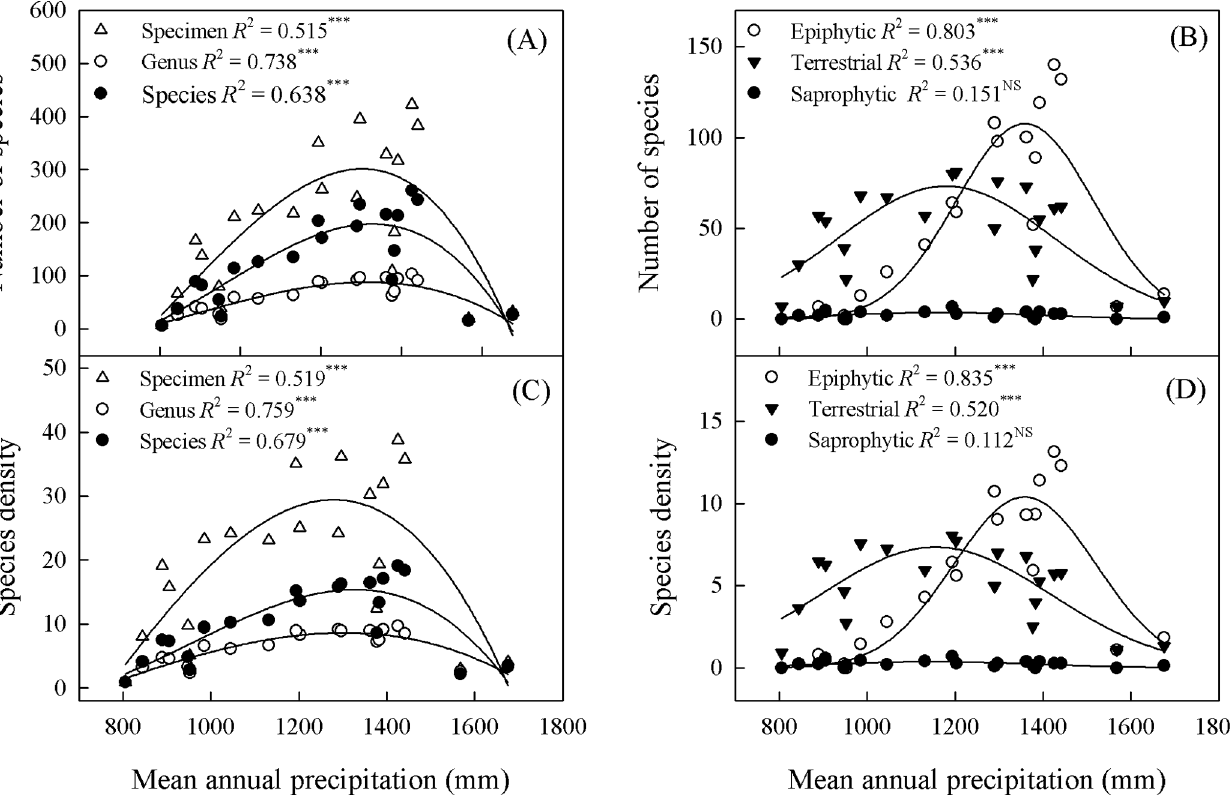
Fig 8. Variations in orchid species richness (SR, panel A-B) and species density (SD, panel C-D) as function of mean annual precipitation (MAP). (A) Specimen: SR = 215.161 − 2.100 * MAP + 0.003 * MAP2 − 1.316 * 10 − 6 * MAP 3 ; Genus: SR = 69.849 − 0.586 * MAP + 0.001 * MAP 2 − 3.545 * 10 − 7 * MAP 3 ; Species: SR = 661.146 − 2.722 * MAP + 0.003 * MAP 2 − 1.149 * 10 − 6 * MAP 3 . (B) Epiphytic: SR = 1678.796 − 4.881 * MAP + 0.005 * MAP 2 − 1.339 * 10 − 6 * MAP 3 ; Terrestrial: SR = -817.875 + 1.874 * MAP – 0.001 * MAP 2 + 2.523 * 10 − 7 * MAP 3 ; Saprophytic: SR = -55.403 + 0.132 * MAP – 9.505 * 10 − 5 * MAP 2 + 2.162 * 10 − 8 * MAP 3 . (C) Specimen: SD = -52.167 − 0.004 * MAP + 2.012 * 10 − 4 * MAP 2 − 8.056 * 10 − 8 * MAP 3 ; Genus: SD = -11.453 − 0.005 * MAP + 4.268 * 10 − 5 * MAP 2 − 2.090 * 10 − 8 * MAP 3 ; Species: SD = 47.612 − 0.194 * MAP + 2.021 * 10 − 4 * MAP 2 − 8.252 * 10 − 8 * MAP 3 . (D) Epiphytic: SD = 151.873 − 0.444 * MAP + 4.011 * 10 − 4 * MAP 2 − -1.229 * 10 − 7 * MAP 3 ; Terrestrial: SD = -97.684+ 0.234 * MAP – 2.002 * 10 − 4 * MAP 2 + 3.751 * 10 − 8 * MAP3; Saprophytic: SD = -6.578+ 0.016 * MAP − 1.217 * 10 − 5 * MAP 2 + 2.922 * 10 − 9 * MAP 3